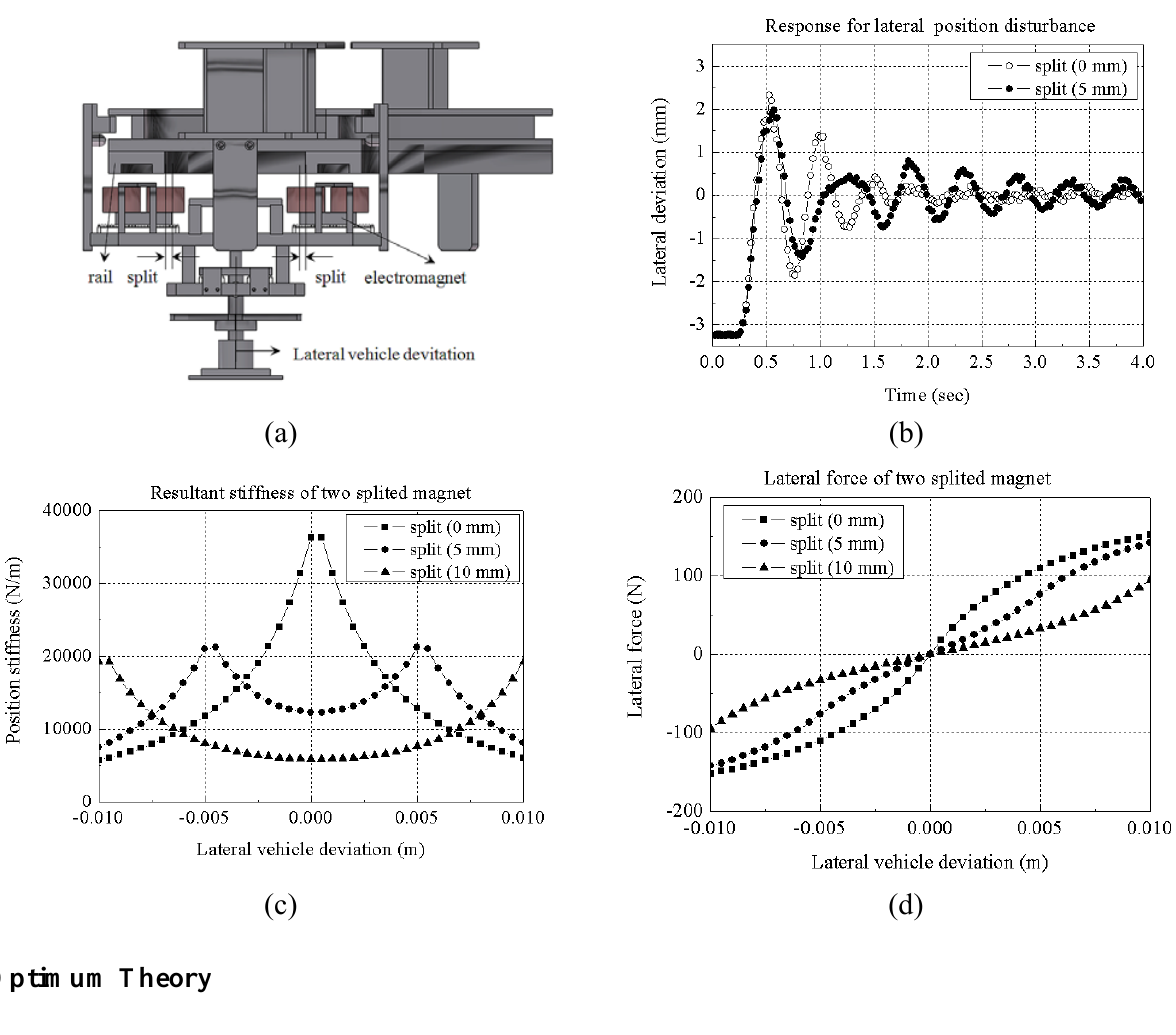
Figure 5. Lateral position response of magnetically sprung mass under position disturbance: (a) experimental model; (b) lateral position response (experiment); (c) lateral position stiffness response (simulation); (d) lateral force response